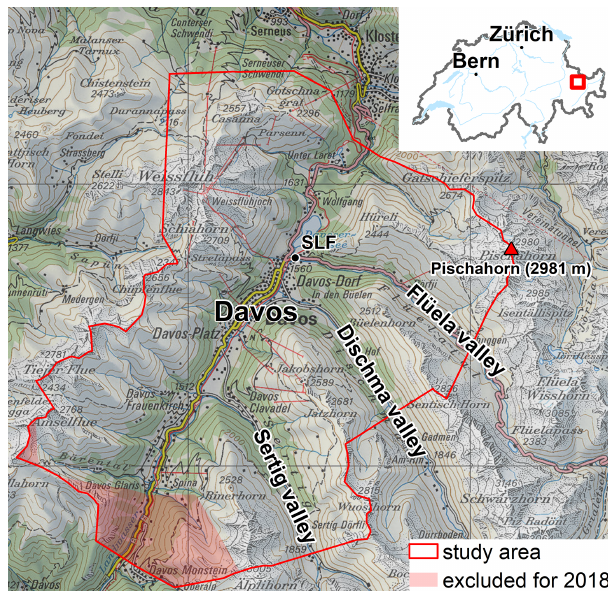
Figure 1. The location of the validation area with the side valleys, the Institute for Snow and Avalance Research (SLF) and the highest point. The red-shaded area was omitted in 2018 due to lack of SPOT satellite data (map source: Federal Office of